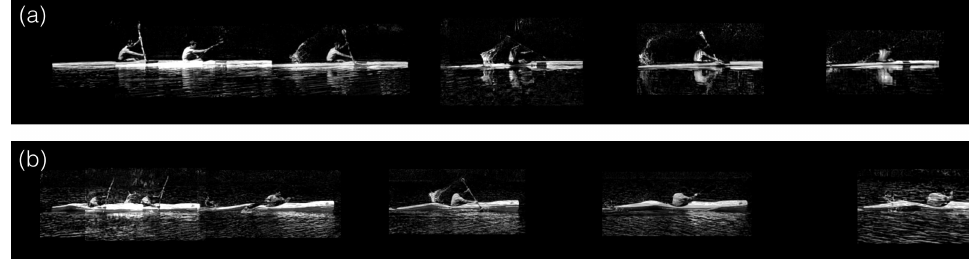
Figure 10. Chronophotography of a standing start. The time lapse between images is ∆ t = 1.67 s: ( a ) Athlete A1. The length scale is given by the length of the boat (5.2 m). ( b ) Athlete A2. The length scale is given by the length of the